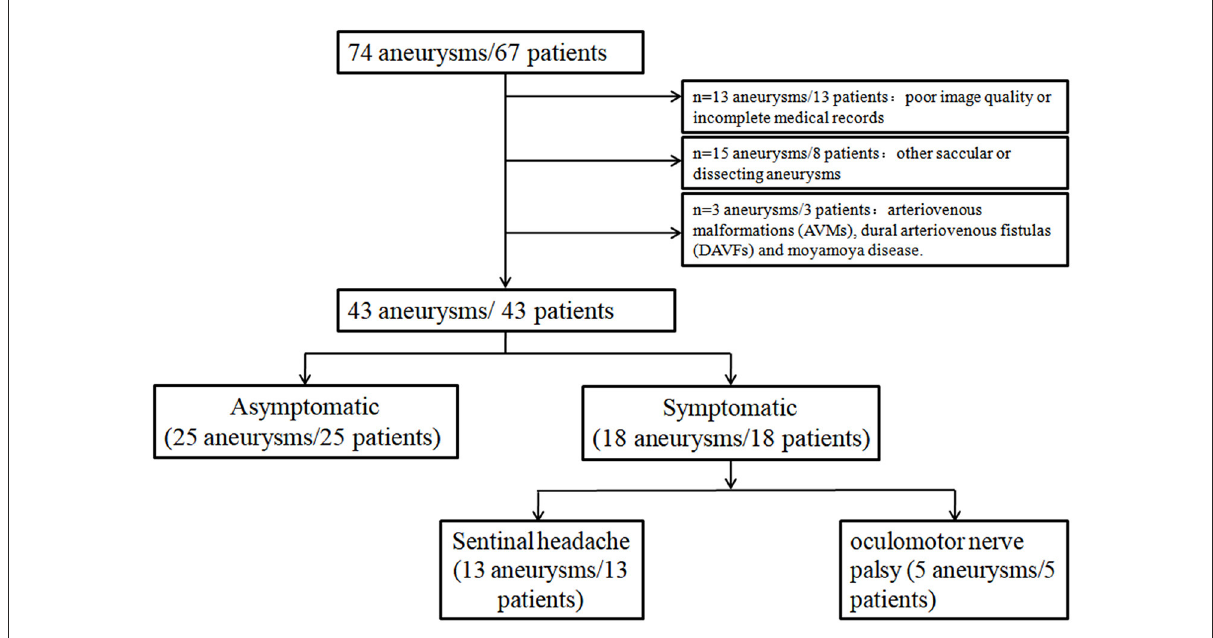
FIGURE2 Flowchart of patients’